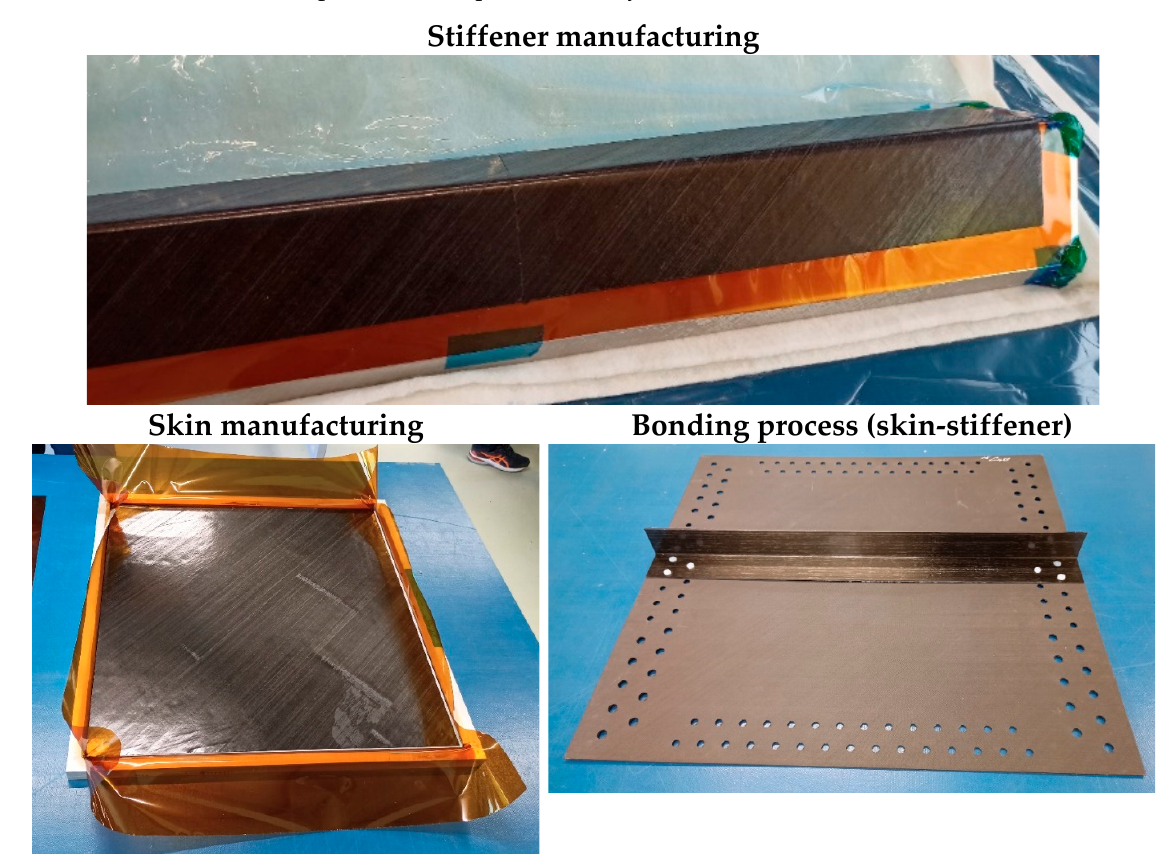
Figure 13. Main steps of the specimen manufacturing process.